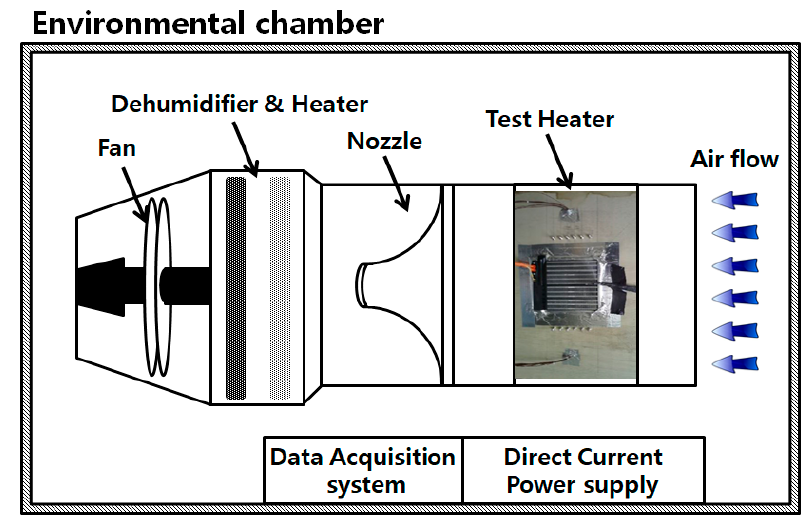
Figure 10. Schematic diagram of the PTC heater experimental apparatus. Table 6. PTC heater experimental conditions.